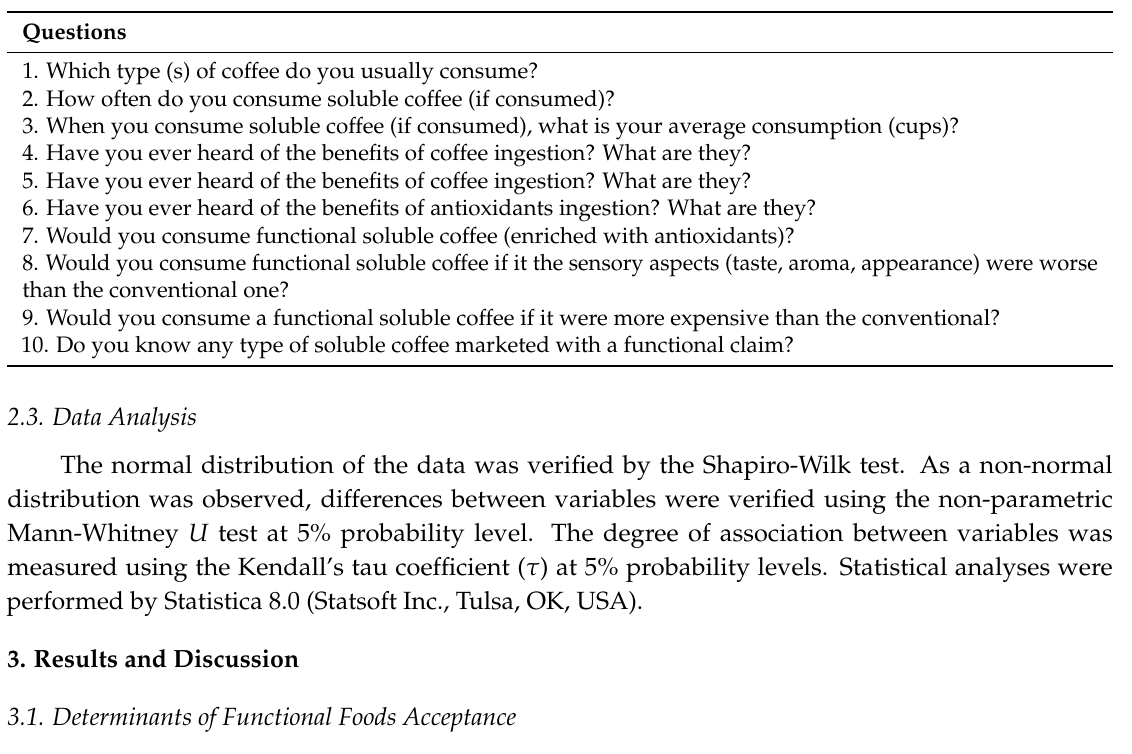
Table 2. Approaches for assessing the demand for soluble coffee enriched with antioxidants.